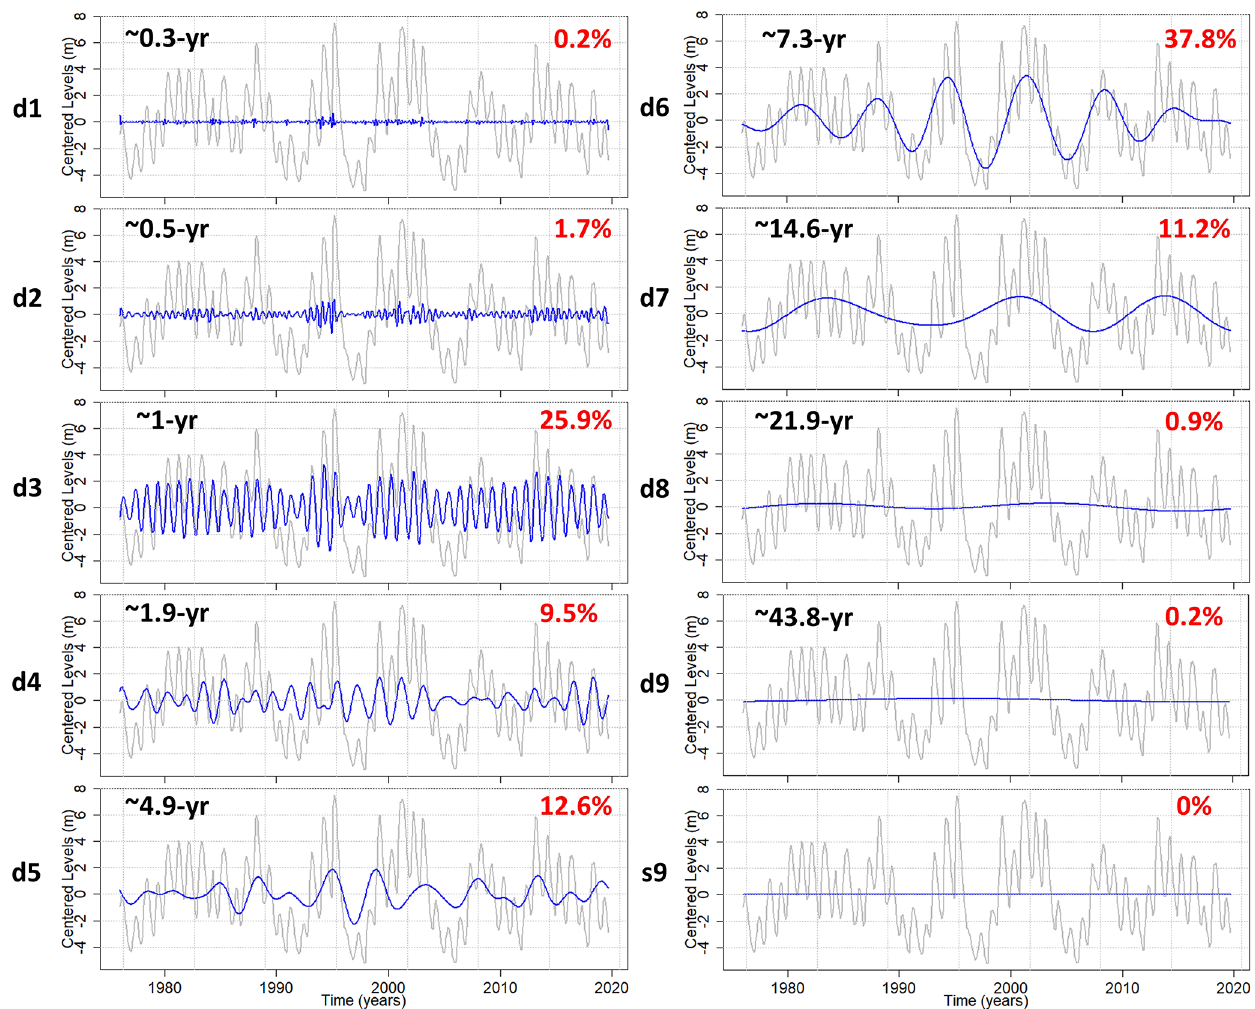
Figure 2. Example of multiresolution analysis by MODWT decomposition for the borehole of Tincques. In gray the groundwater level time series in Tincques is presented and in blue the wavelet details (d1 to d9) and the last smooth or approximation (s9). The Fourier period (in black) and energy percentage (in red) associated with each detail can be